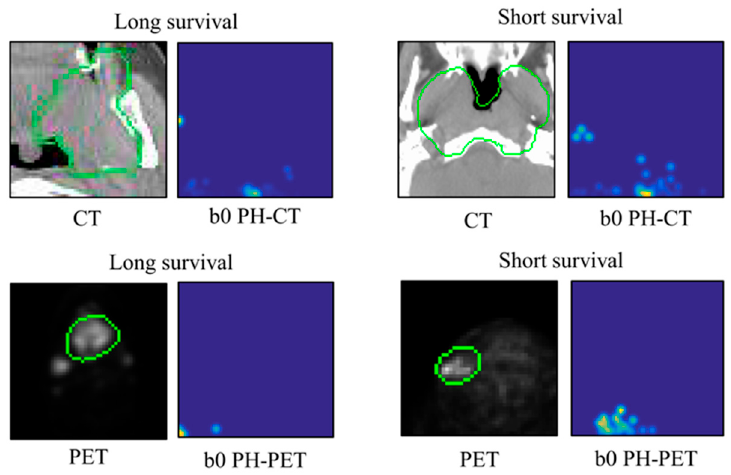
Figure 3. Illustrations of b0 PH-CT and PH-PET images for long- and short-survival patients. PH: persistent homology; CT: computed tomography; PET: positron emission tomography; the green circle represents gross tumor volume .